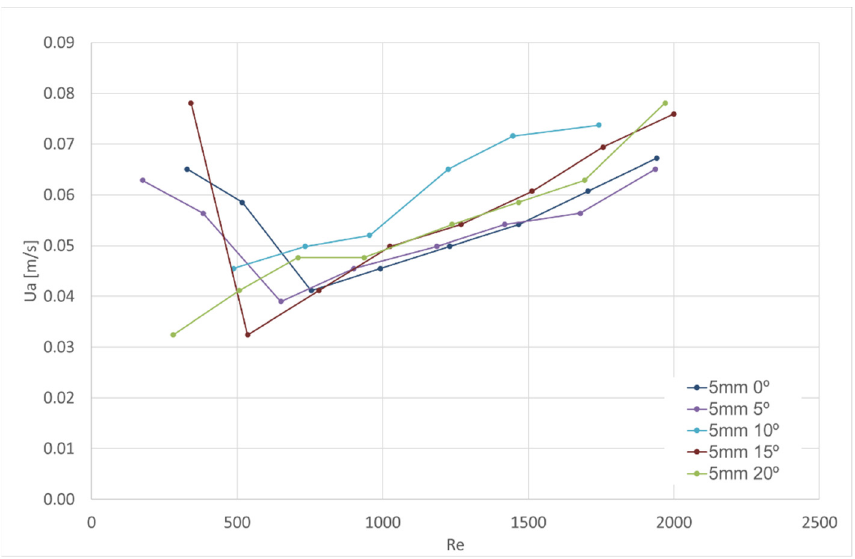
Figure 6. Test results for visual aerodynamic sealing of the air curtain for the nominal nozzle thickness of 5 mm.